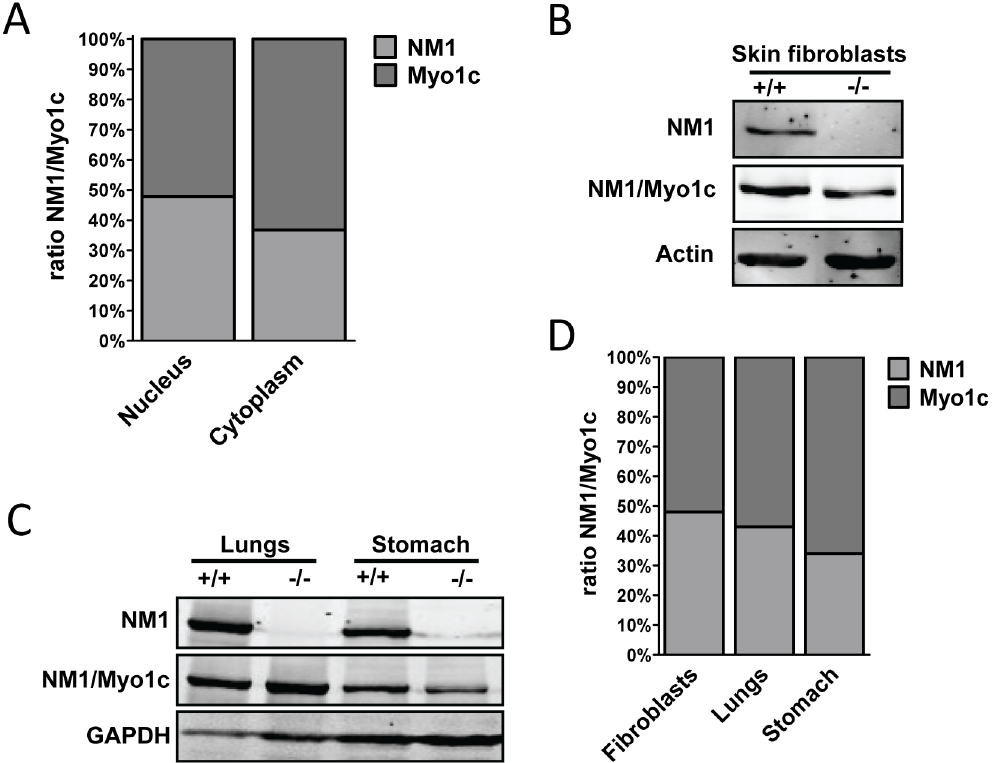
Figure 4. Ratio between NM1 and Myo1c is nearby equal. ( A ) HeLa cells were fractionated into cytosolic and nuclear fractions. NM1 and Myo1c amounts were quantified using double fluorescent labeling of western blot membranes after normalization to NM1-GFP band. ( B ) Total amounts of NM1 + Myo1c were compared in mouse skin fibroblasts derived from NM1 knock-out and NM1 wild type mouse. Beta actin signal was used as loading normalizer. ( C ) Total amounts of NM1 + Myo1c were compared in lungs and stomach from NM1 knock out and NM1 wild type mouse. GAPDH signal was used as loading normalizer. ( D ) The graph shows the amount of NM1 and Myo1c after densitometric quantification of bands from figures 4B and 4C showing the ratio between NM1 and Myo1c as compared to actin/GAPDH expression.